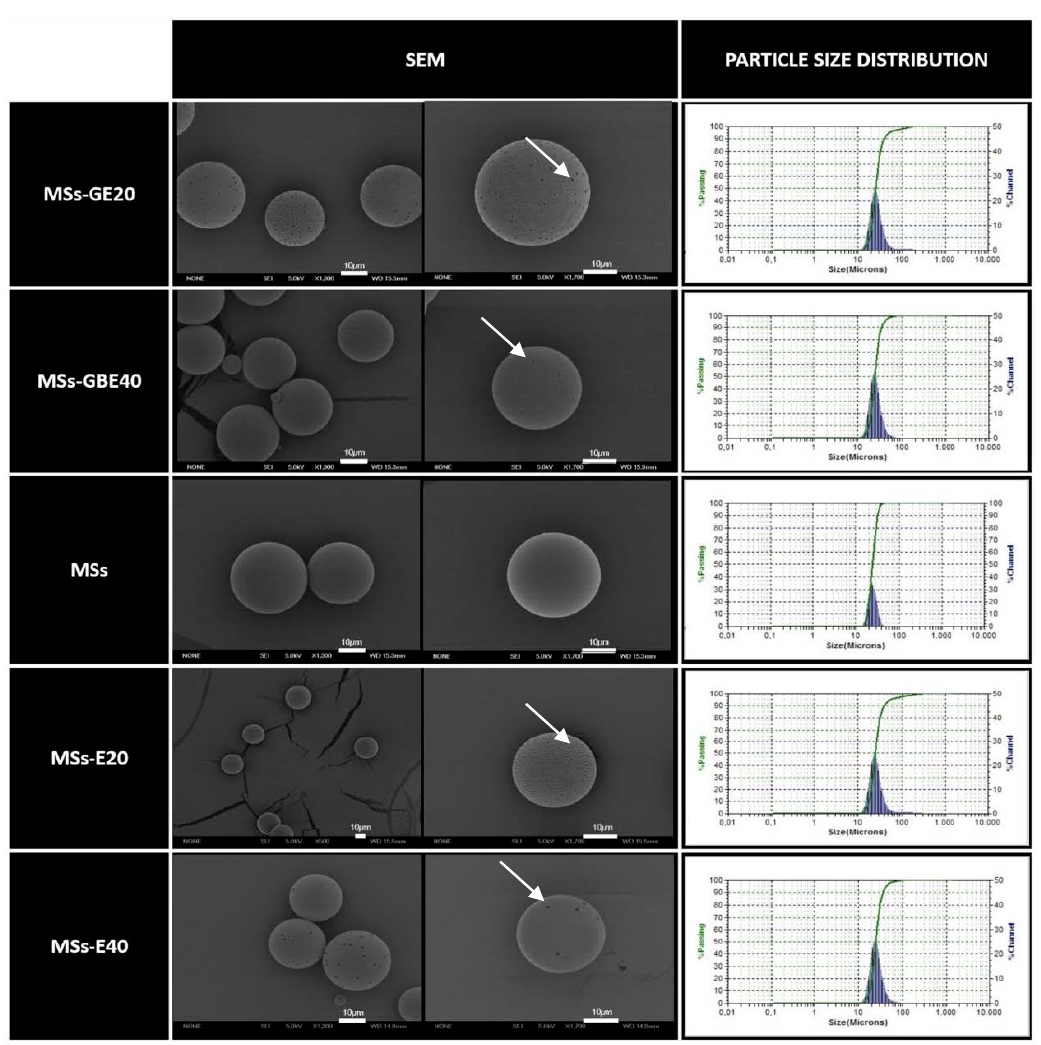
Figure 1. Microsphere (MS) characterization. Morphological evaluation by scanning electron microscopy (SEM) and particle size distribution. Blank MSs (MSs); MSs/VitaminE(20) (MSs-E20); MSs/VitaminE(40) (MSs-E40) GDNF/VitE(20)-loaded PLGA MSs (MSs-GE20); GDNF/BDNF/VitE(40)-loaded PLGA microspheres (MSs-GBE40). SEM investigation showed the presence of spherical particles with comparable and regular size distributions, which were confirmed by particle size measurements. White arrows: pores on the MS surfaces. Scale bar: 10 µm.